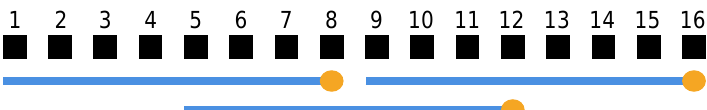
Figure 7. Representation of the window analysis and overlapping techniques ( W size = 8, W over = 50%). The black squares represent the predicted information points, the blue lines represent the windows and the orange dots are the resulting information point of each